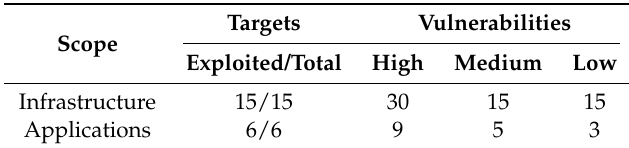
Table 2. Results: First